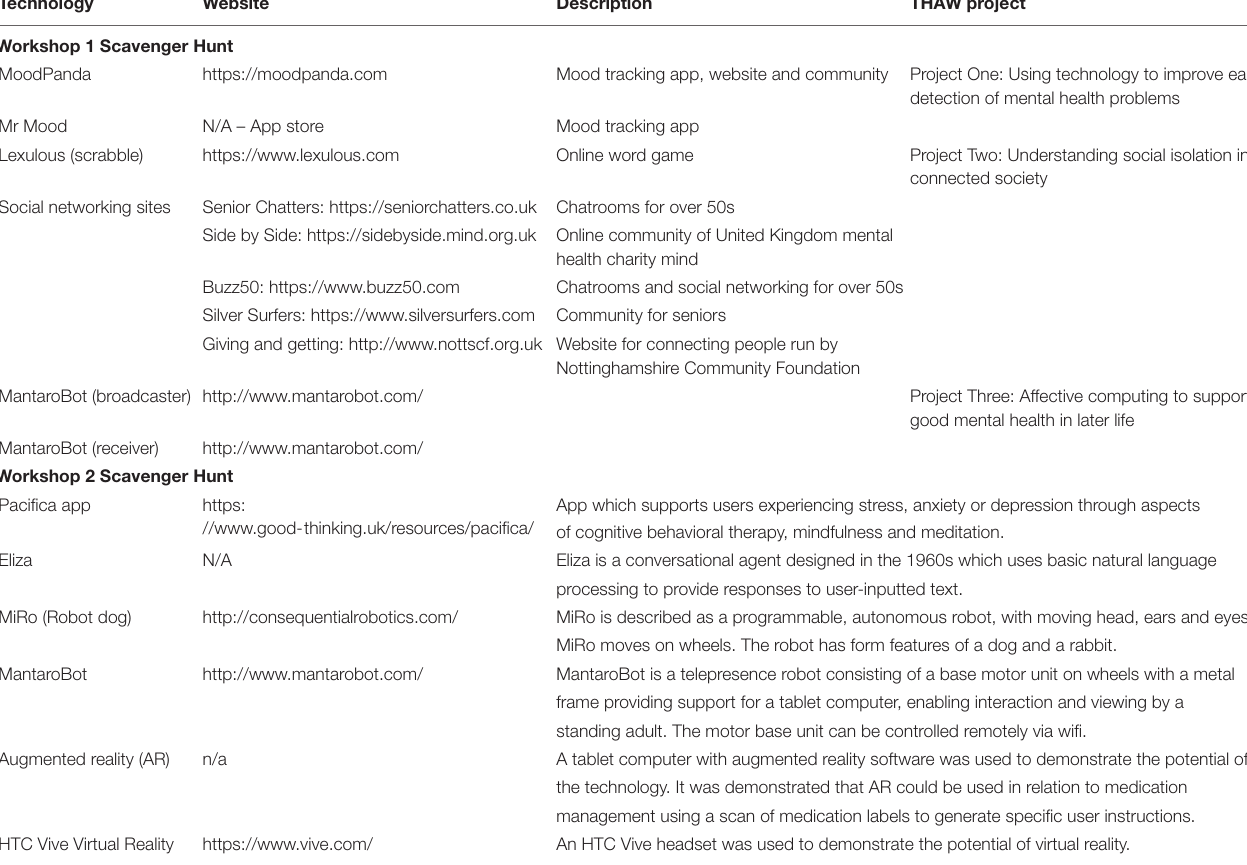
TABLE 2 | Technological apps/equipment used for Workshop 1 and Workshop 2 Scavenger